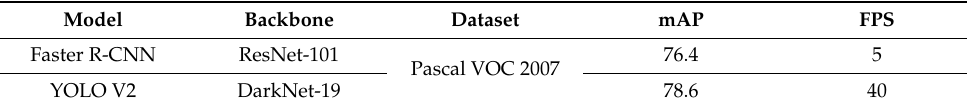
Table 5. Comparison Performance of Faster R-CNN and YOLO V2.